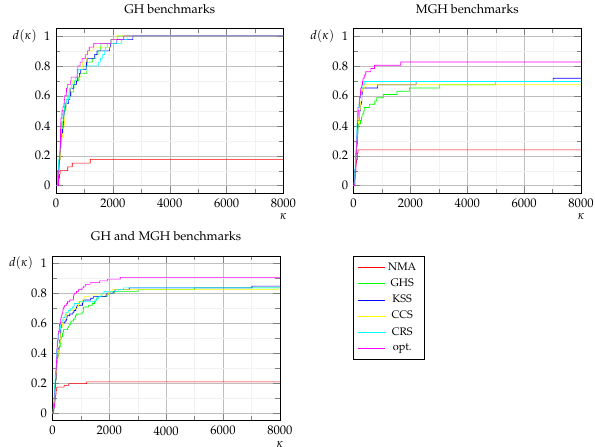
Figure 4. Data profiles for GH and MGH benchmark sets, separated and combined. Tolerance-based algorithm termination was applied ( Tol f = Tol X = 10 − 4 The advantage of the optimized schema becomes apparent in MGH data profiles. 287 TheKSS,CCS,andCRSkeeppaceforupto~370simplexgradientestimateswhere~70% 288 of the MGH problems are solved. The GHS starts to lag at ~240 estimates with ~40% of 289 the problems solved. It catches up at 3000 estimates, finally solving 70% of the MGH 290 problems. KSS, the best of the existing adaptive schemas, ends at 71%. The optimized 291 schema is clearly better with 80% of the problems solved in 730 estimates, ending with 292 82% at 1660 estimates. The original NMA again performs worse compared to the run 293 without tolerance-based termination, ending with 23% of solved problems. 294 For all-inclusive, GH and MGH benchmark data profiles, the optimized schema 295 starts to stand out from the rest of the existing adaptive schemas at ~60% of solved 296 problems, achieved within ~300 simplex gradient estimates. The optimized schema 297 reaches its final result, i.e., 90% of solved problems, in 2400 estimates. Its advantage 298 over the best existing adaptive schema, i.e., KSS, is 6%. The KSS comes to 84% in 7020 299 estimates. As expected, the original NMA ends at a modest 21% of solved problems 300 within 1200 estimates. 301 Figure5showsourlastconvergencespeedmeasurementonGH,MGH,andCUTEr 302 benchmark problems, 169 problems in total. The data profiles are shown for the CUTEr 303 benchmark set, and GH, MGH, and CUTEr benchmark sets combined. They are cal- 304